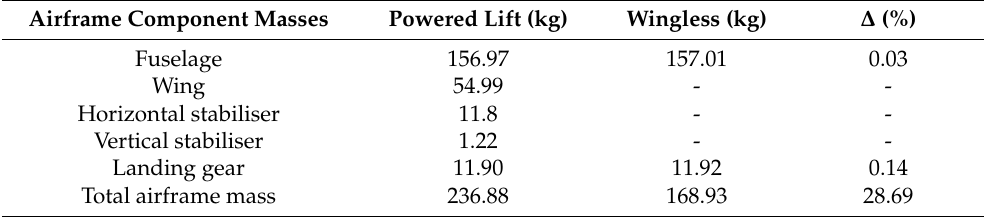
Table 5. Airframe component mass breakdown for powered lift and wingless eVTOL aircraft types.